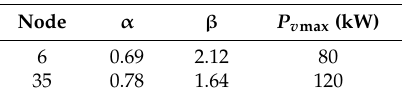
Table 10. Parameters in probability model of